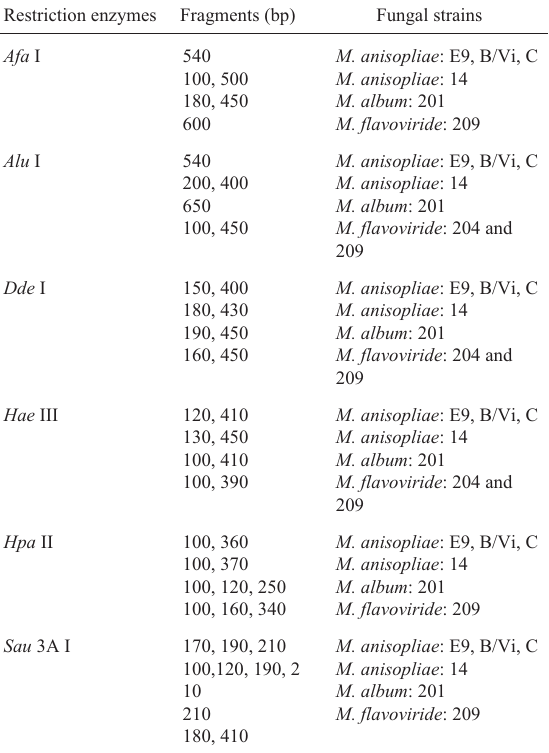
Table 2 - RFLP profiles produced by digestions of the ITS-PCR products with different restriction enzymes. Restriction enzymes Fragments